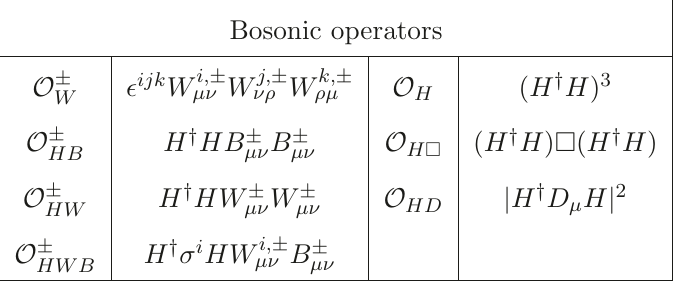
± ± ( i = c X i ˜ c X . Note that the operators ˜ X ) / 2 and c X ≡ X O O X ∓ O ±